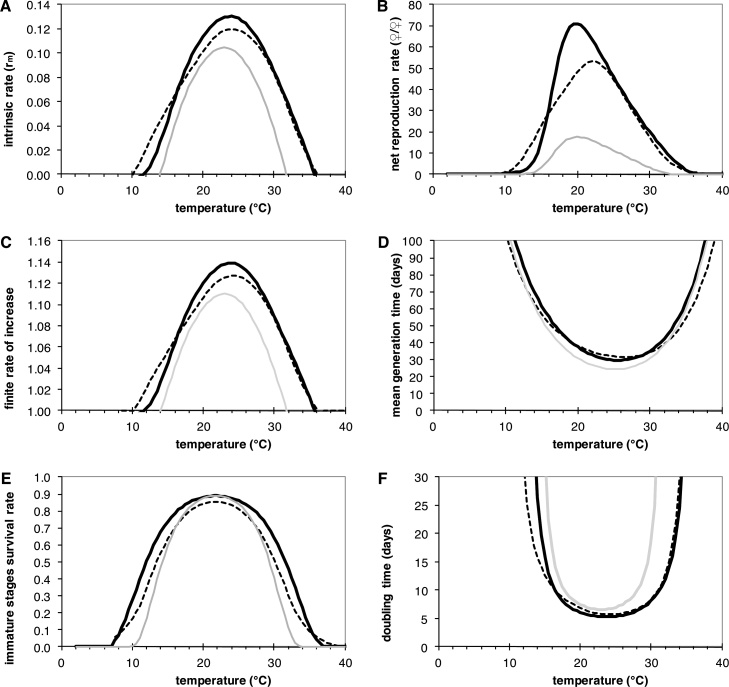
Life table parameters of T. vaporariorum simulated using the adjusted phenology model developed in this study over a temperature range from 0 to 40 °C. (A) intrinsic rate of natural increase (rm), (B) net reproduction rate (R0) [females/female], (C) finite rate of increase (λ), (D) mean generation time (T) [days], (E) Immature stages survival rate, (S) doubling time (Dt) [days]. Black line: adjusted model prediction if temperature is held constant; scattered black line: adjusted model prediction if temperature fluctuates ±5 °C (x-value ±5 °C); grey line: original model prediction at constant temperatures.